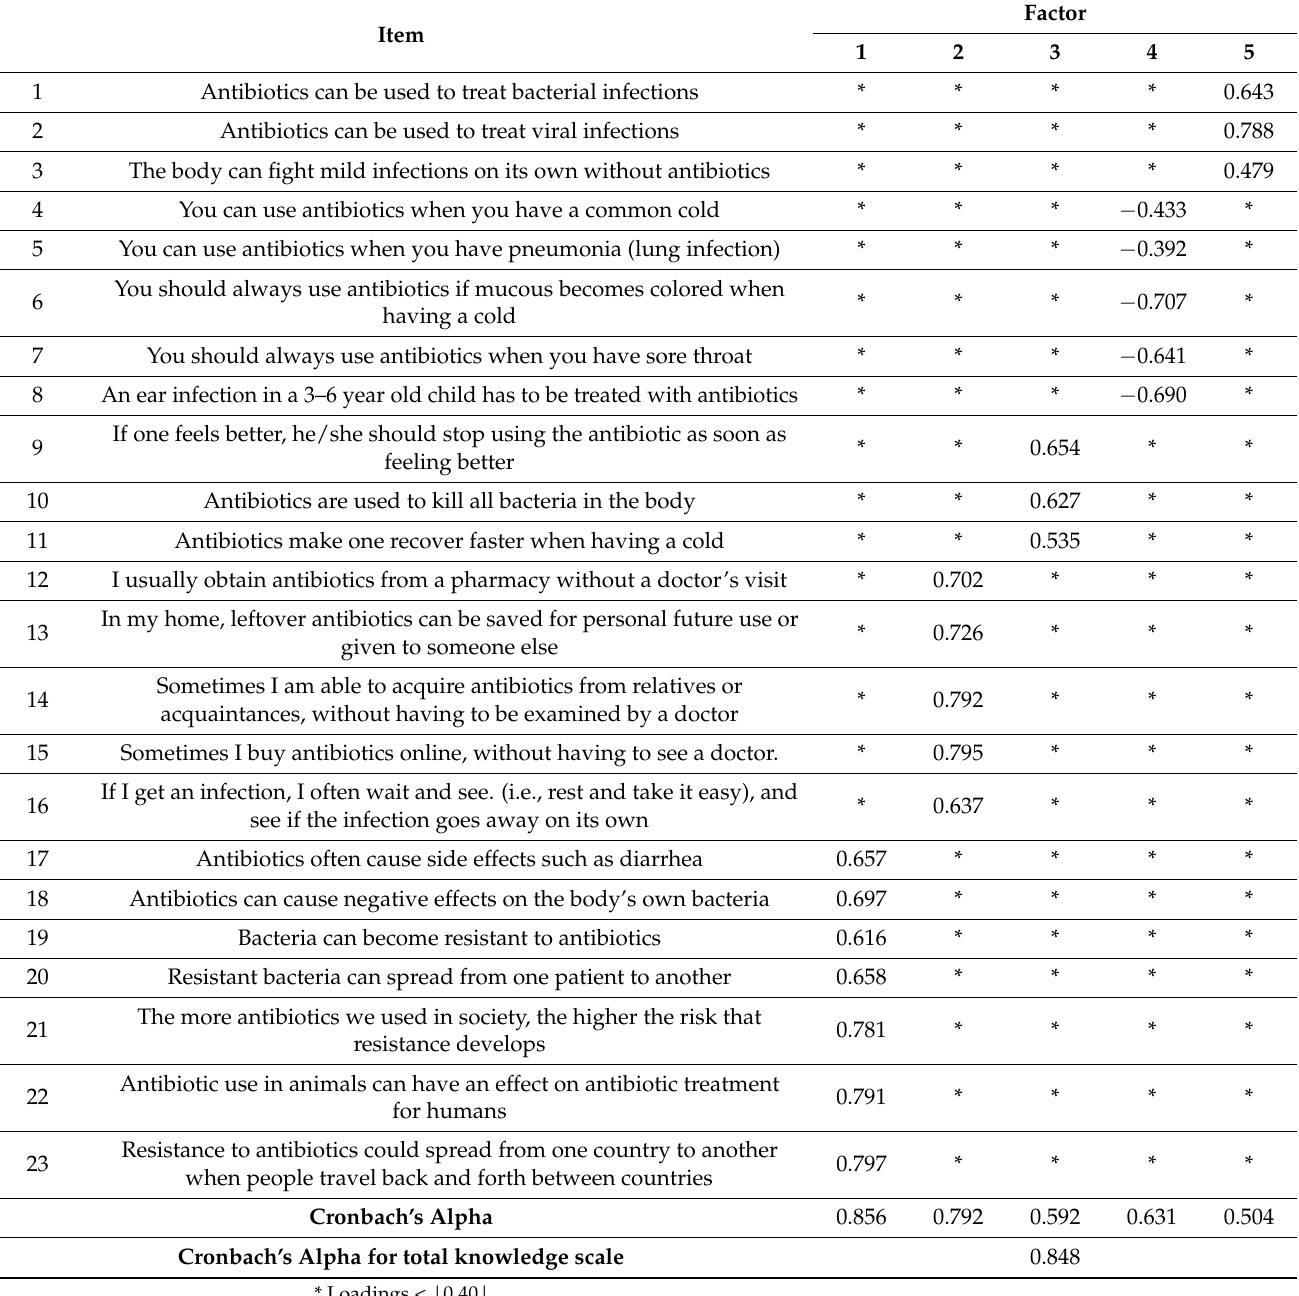
Table 3. Rotated component matrix and consistency reliability of the 23-item knowledge